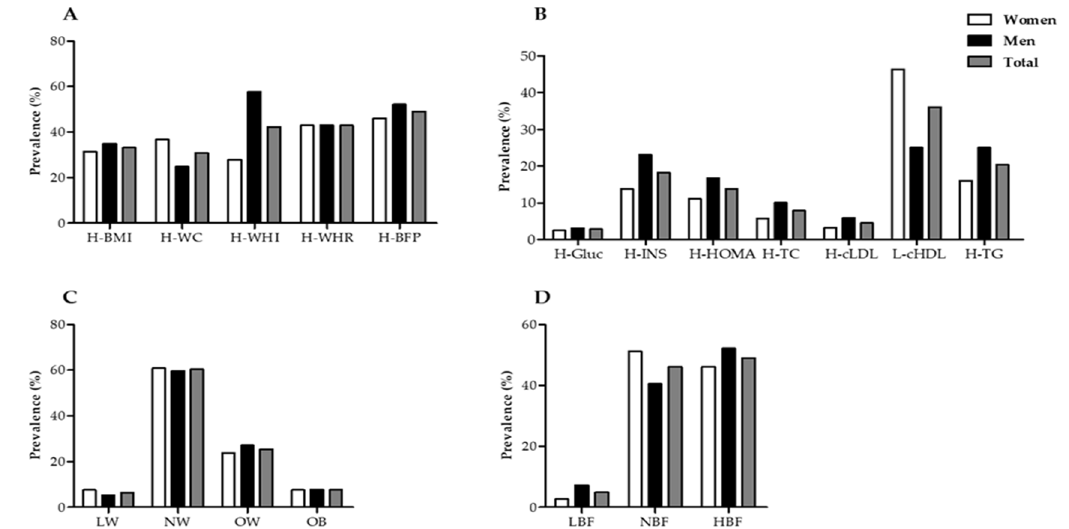
Figure 1. Distribution of nutritional status ( A ) Prevalence of anthropometric and body composition